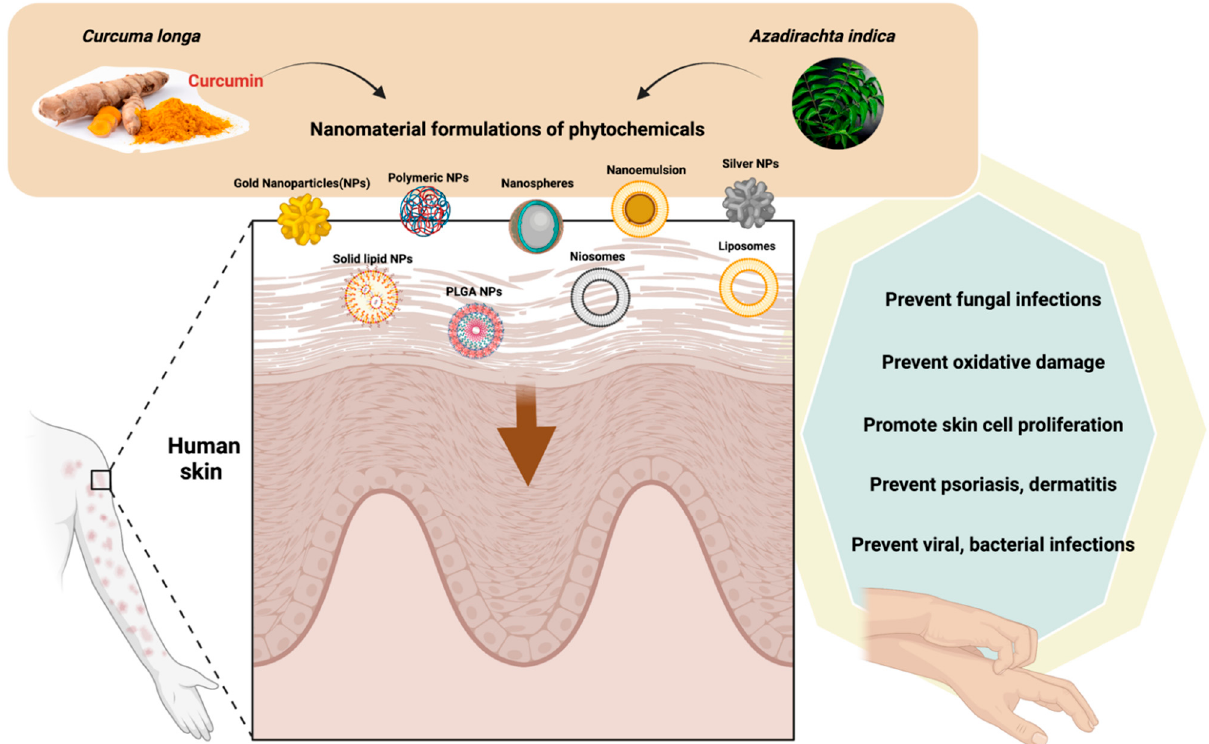
Figure 2. The uses of nanomaterials with phytochemicals of Curcuma longa and Azadirachta indica oil in dermatological disorders. The figure was made with www.biorender.com (access date: 15 March 2022).